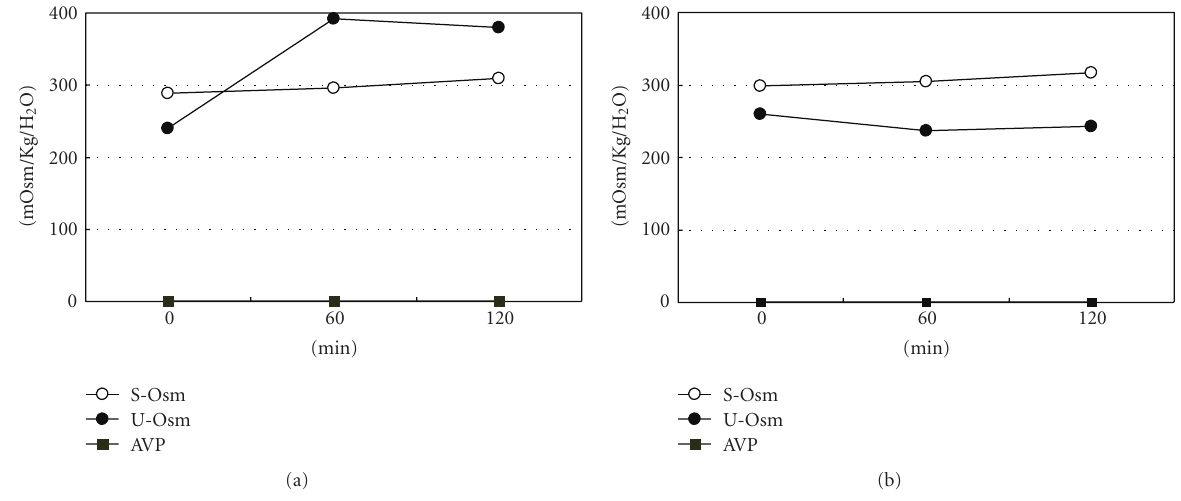
Figure 2: Hypertonic saline test before (a) and after (b) glucocorticoid therapy. Before therapy, although plasma AVP was undetectable, urine became concentrated. After therapy, the hypertonic saline test failed to concentrate the urine and AVP was